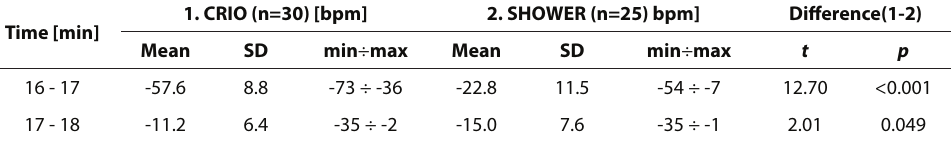
TABLE 5. Changes in resting heart rate at one-minute intervals (in the 17 th and 18 th minute) Time